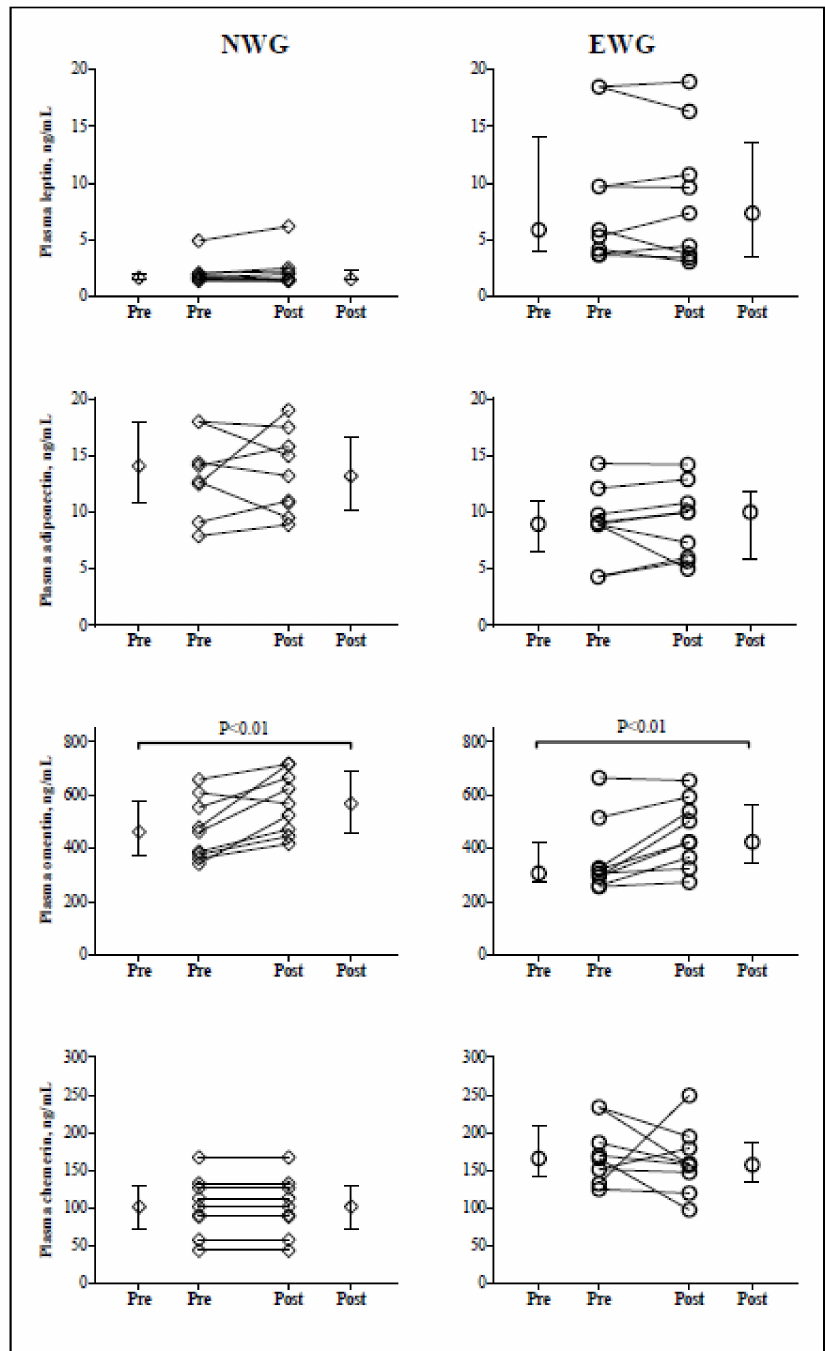
Figure 1. Changes in circulating Omentin-1, adiponectin, leptin, and chemerin concentrations following eight-week high-intensity interval training (HIIT) among normal-weight group (NWG) and excess-weight group (EWG); P-value (compared to pre-training program in the same group). 3.3. Correlations of Training-Induced Adipokines and Cardiometabolic Markers Changes HIIT-induced changes in chemerin were positively related to changes in BMI and TG. Adiponectin changes were negatively related to changes in TG and CRP. No other correla- tions were found between adipokines and cardiometabolic markers changes (Table